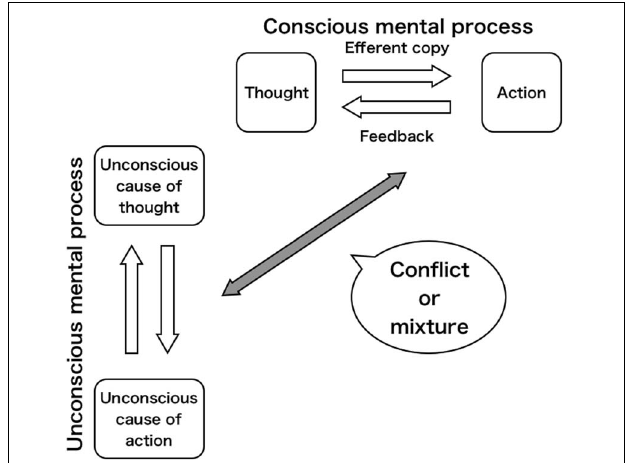
FIGURE 1 | Duality of mental process.